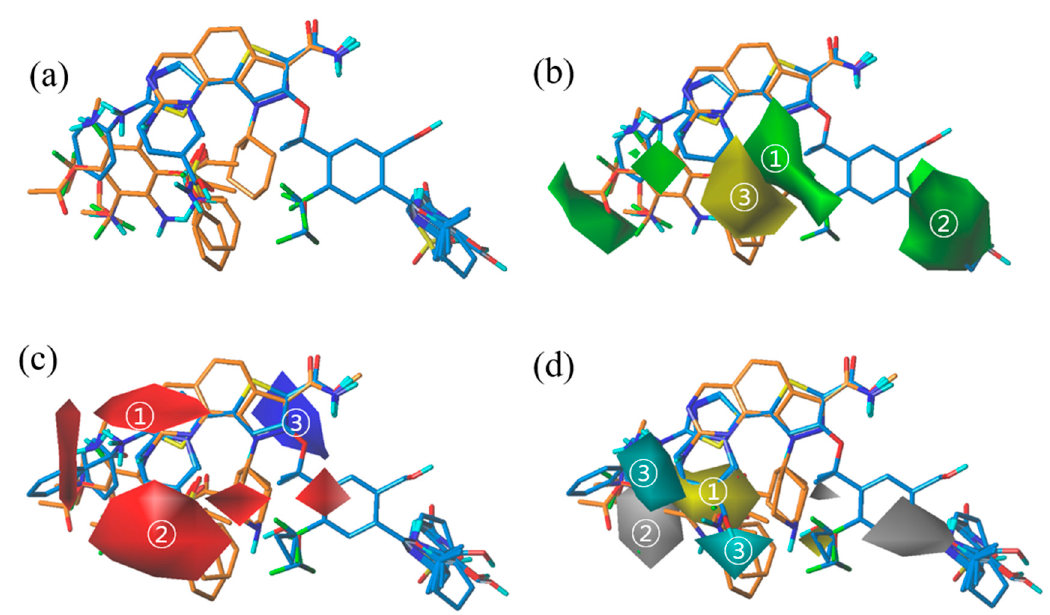
Figure 3. ( a ) Alignment of two series of compounds. Thiophene-2-carboxamide (cyan) and 8-amino-4, 5-dihydro-1 H - pyrazolo[4,3-h]quinazoline-3-carbaldehyde derivatives (orange). ( b ) CoMFA steric contour map, ( c ) CoMFA electrostatic contour map, and ( d ) CoMSIA contour map. Table 1. PLS results of final CoMFA and CoMSIA models.